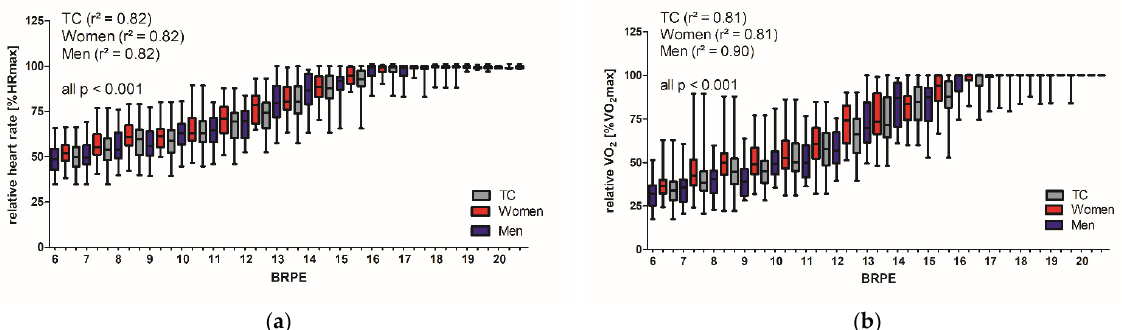
Figure 1. Measurements of exercise intensity and BRPE on the treadmill: differences between genders. ( a ) Relative HR (%HR max ) and ( b ) relative ˙VO 2 (%VO 2max ) at different BRPE values for the total cohort (TC), women and men.